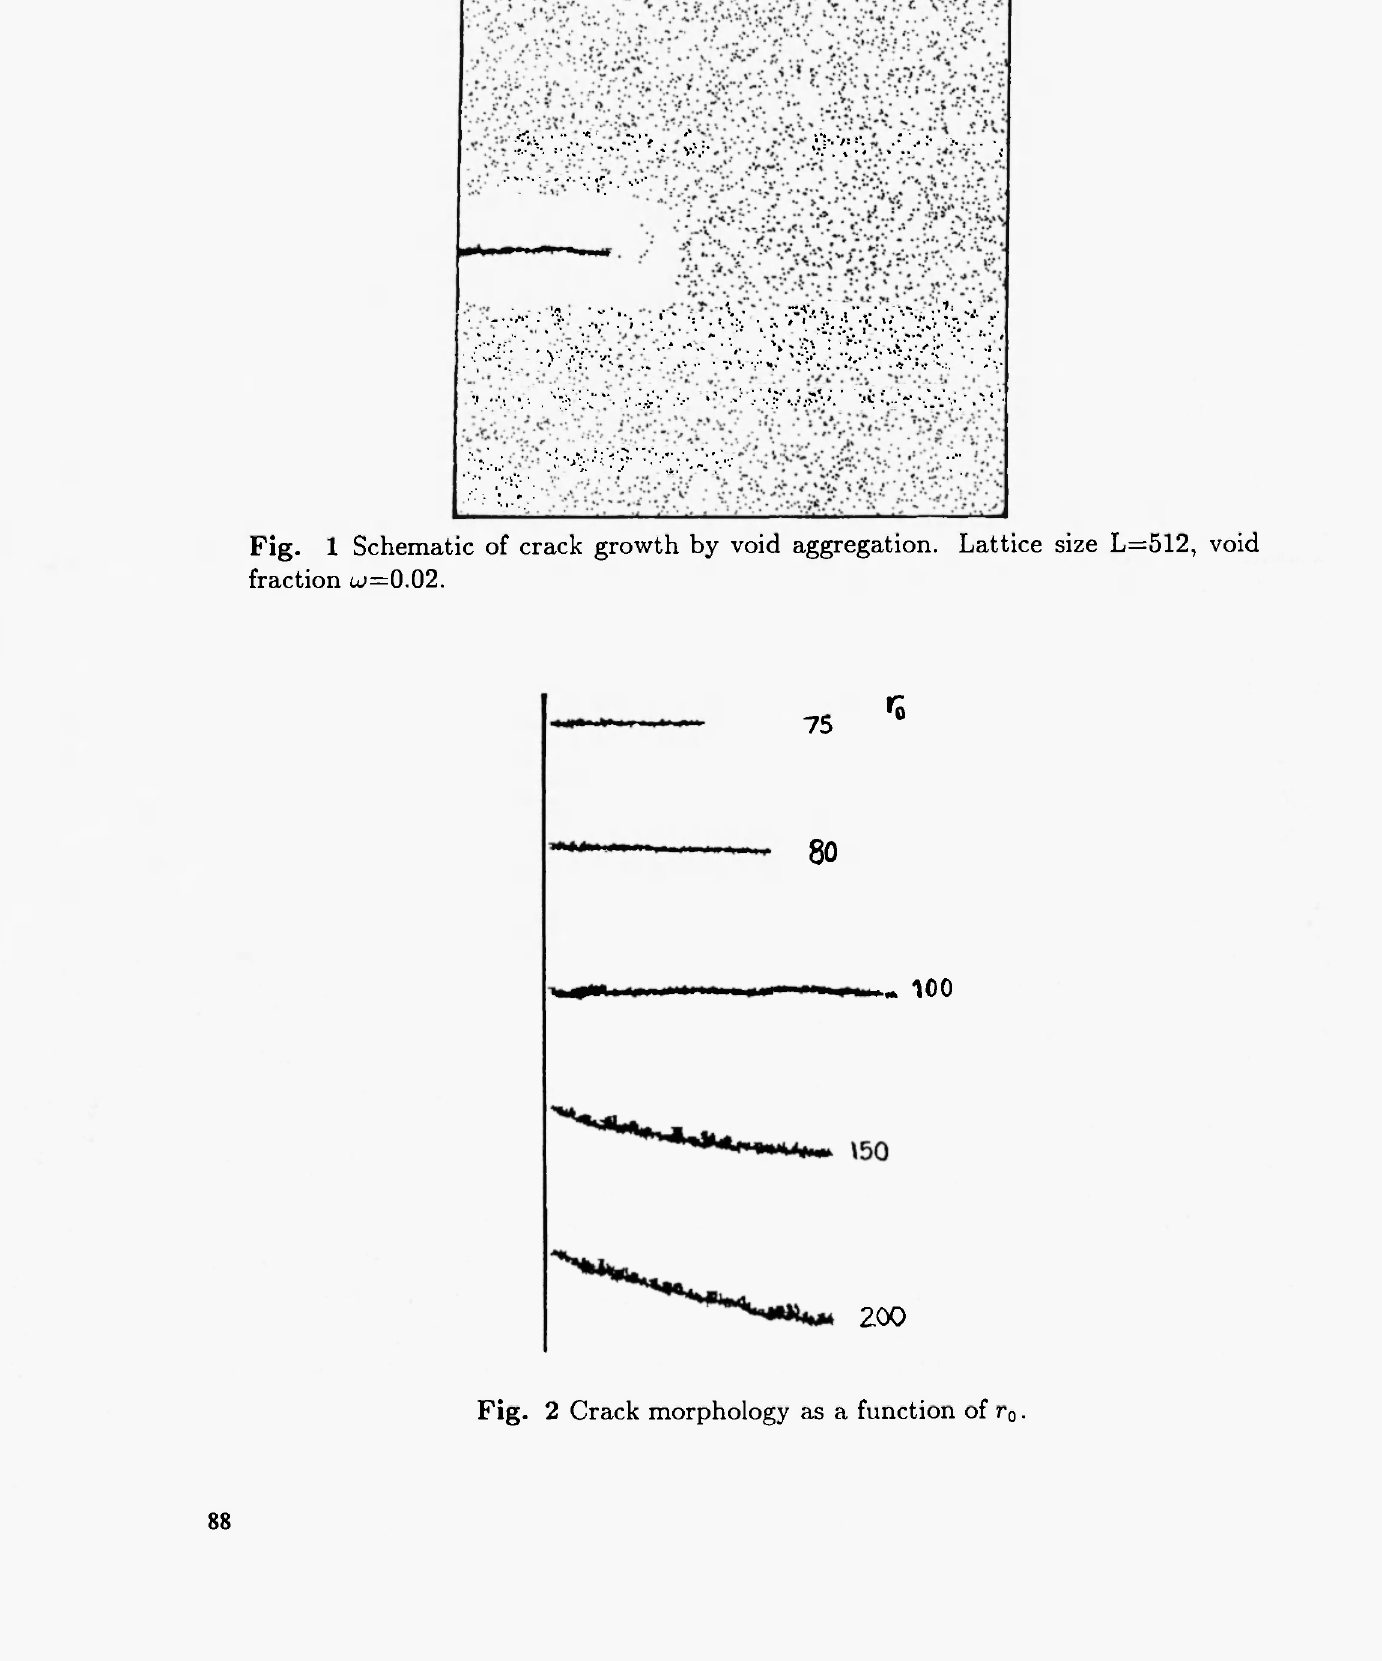
Fig. 2 Crack morphology as a function of r